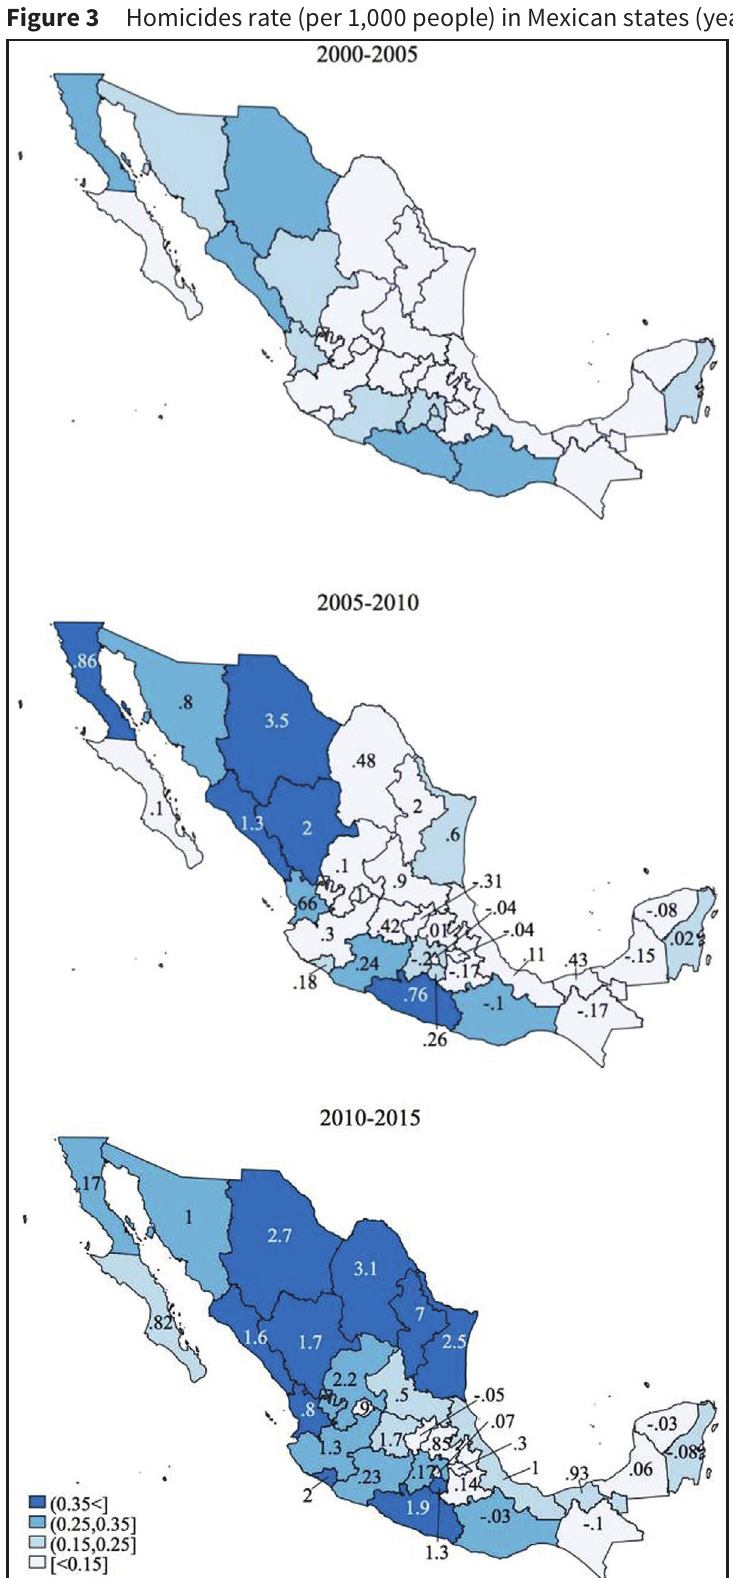
Homicides rate (per 1,000 people) in Mexican states (yearly average), by period